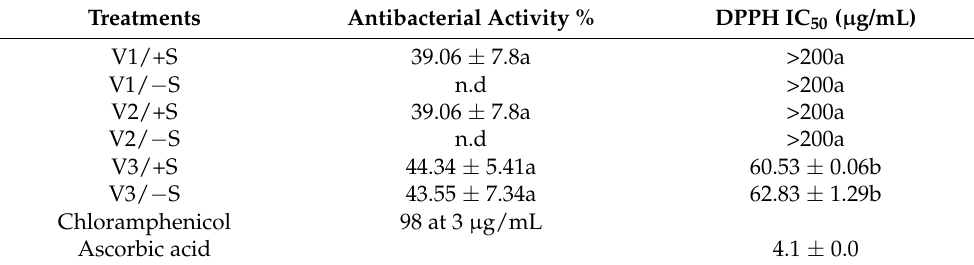
Table 5. Antibacterial activity (%) against S. aureus at test concentrations of 200 µ g/ml and DPPH radical scavenging activity of three lettuce cultivars V1–V3 grown under both +S and − S conditions. Treatments Antibacterial Activity